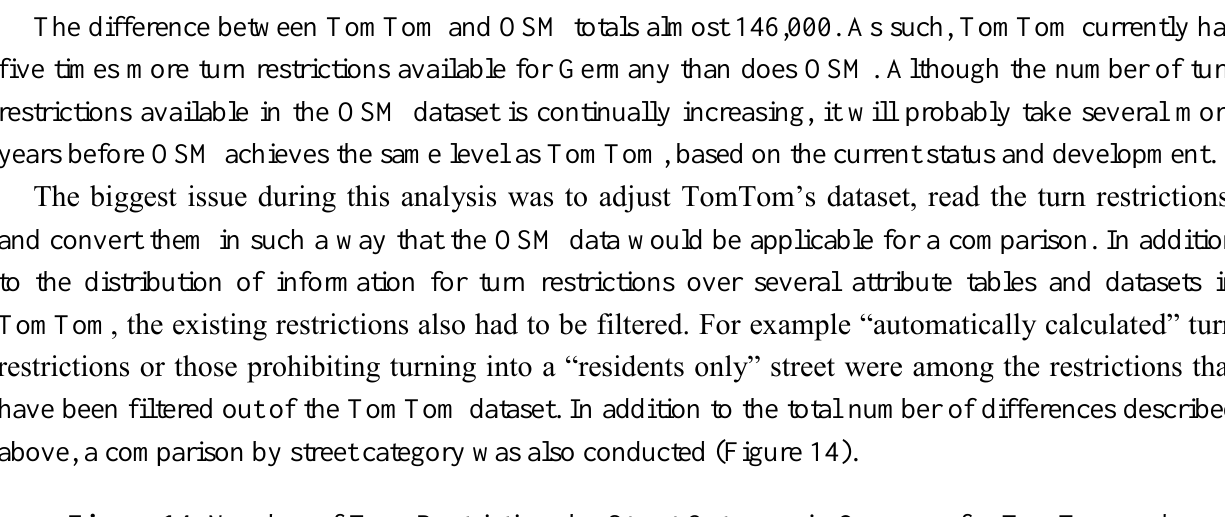
Figure 14. Number of Turn Restrictions by Street Category in Germany for TomTom and OSM (June